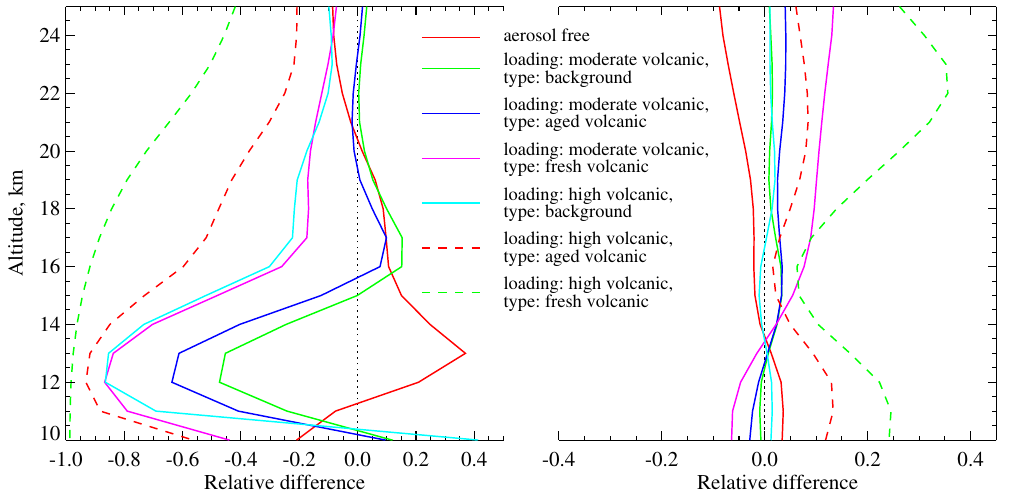
Fig. 14. Relative retrieval errors due to stratospheric aerosol for a tropical measurement with (right panel) and without (left panel) strato- spheric aerosol correction.